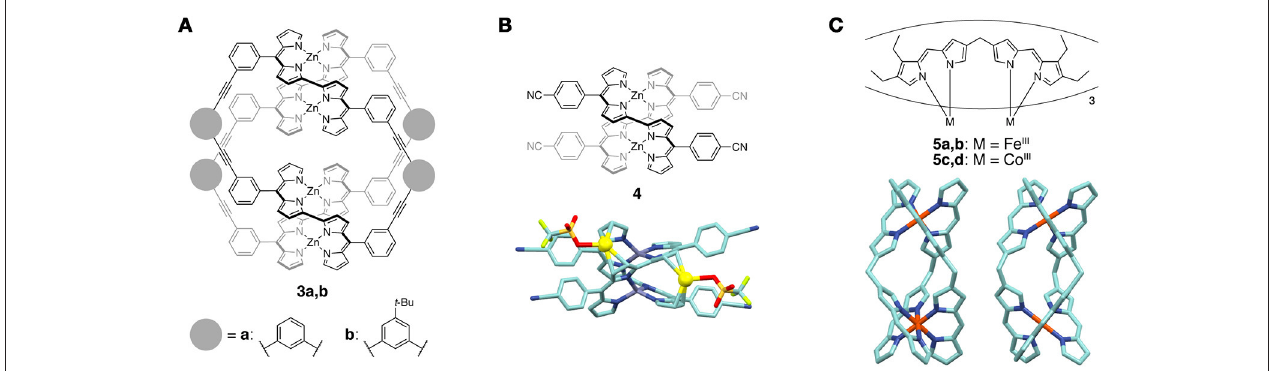
FIGURE 3 | (A) Double helical complexes 3a , b that show thermally responsive spring-like motions. (B) (top) Chemical structure of Zn(II) double helicate 4 . (bottom) Molecular structure of the complex of 4 , Ag(OTf), and THF determined by X-ray crystallography. THF and hydrogen atoms are omitted for clarity. The Ag(I) ions in the π -clefts of 4 are highlighted as yellow balls. (C) (top) Chemical structures of triple-stranded M 2 L 3 complexes 5a – d . (bottom) Molecular structure of helicate 5a (left) and mesocate 5b (right) determined by X-ray crystallography. Hydrogen atoms and peripheral ethyl substituents are omitted for clarity.